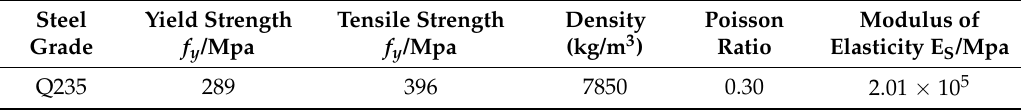
Figure 8. Test equipment: ( a ) Steel tube (wall thickness 300 mm); ( b ) Bottom plate (diameter 170 mm); ( c ) Cover plate (diameter 130 mm). Table 3. The material properties of steel.